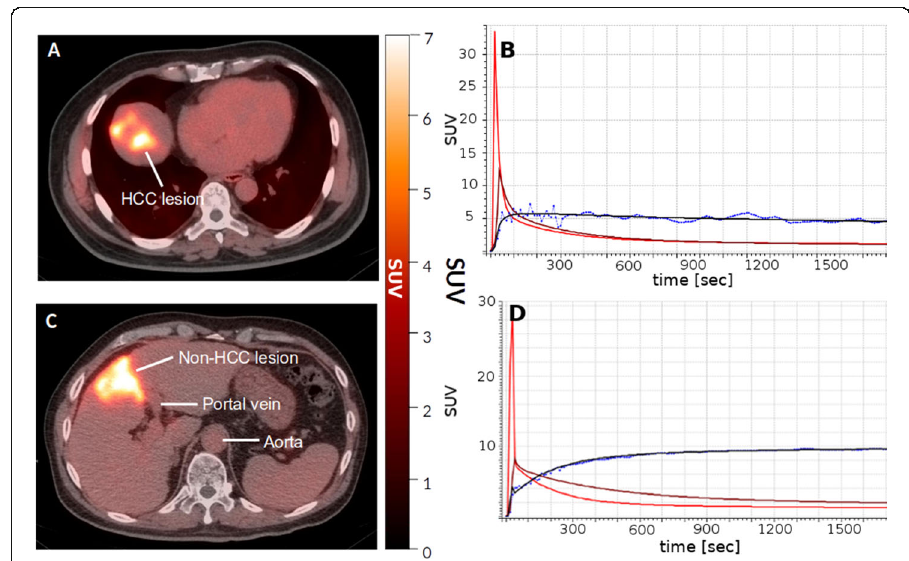
Fig. 1 Representative image ( a ) shows HCC lesion of a 63-year-old male patient, as well as the corresponding time-activity curves (TACs) ( b ). Representative image ( c ) shows non-HCC lesion, artery, and portal vein of a 64-year-old male patient, as well as the corresponding TACs from delineated regions ( d ). For the sake of visibility, the mean SUV values in case of artery and vein are displayed